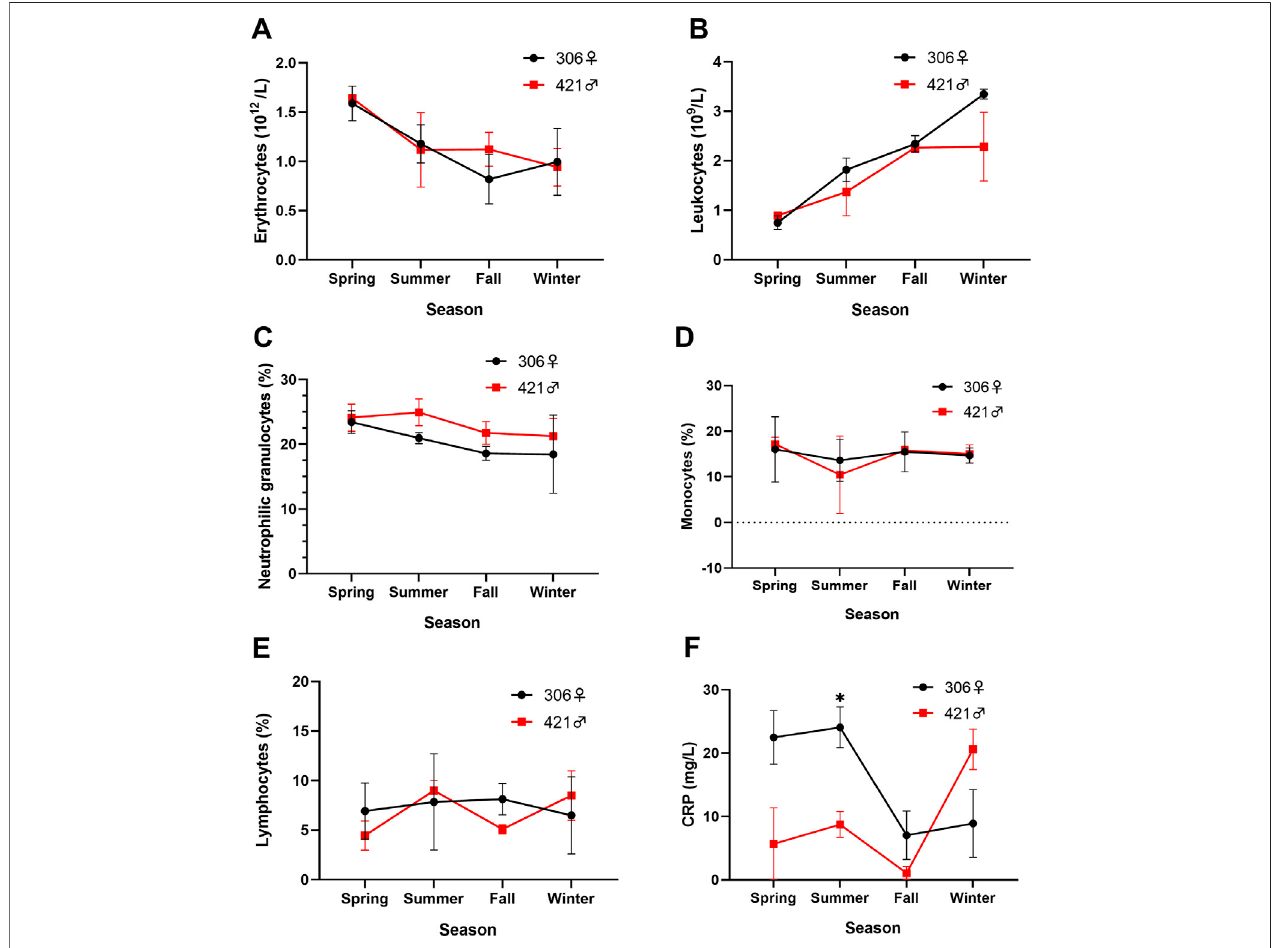
FIGURE3| Seasonalvariationof (A) erythrocytes, (B) leukocytes, (C) neutrophilicgranulocytes, (D) monocytes, (E) lymphocytes,and (F) C-reactiveprotein(CRP) in the blood of two Chinese sturgeons. Data are mean ± SEM ( n = 3), the seasonal data of sample size ( n = 3) represents the three monthly data within one season. Signi fi cant difference ( p < 0.05) in the parameter between the male and female individuals in the same season is denoted by an asterisk. Dashed line represents zero value.